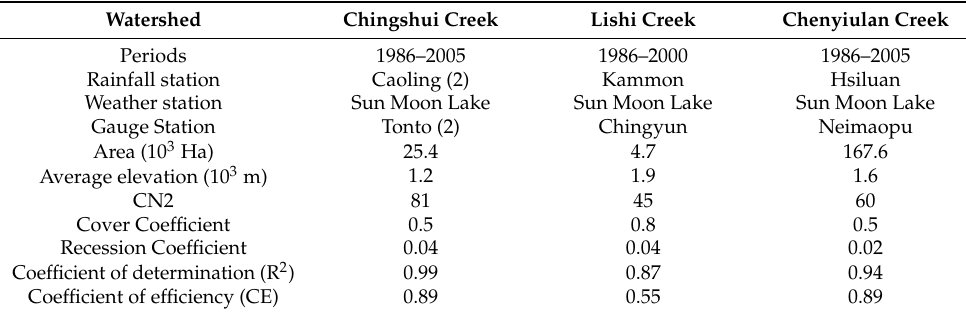
Table 2. Parameters and results for GWLF